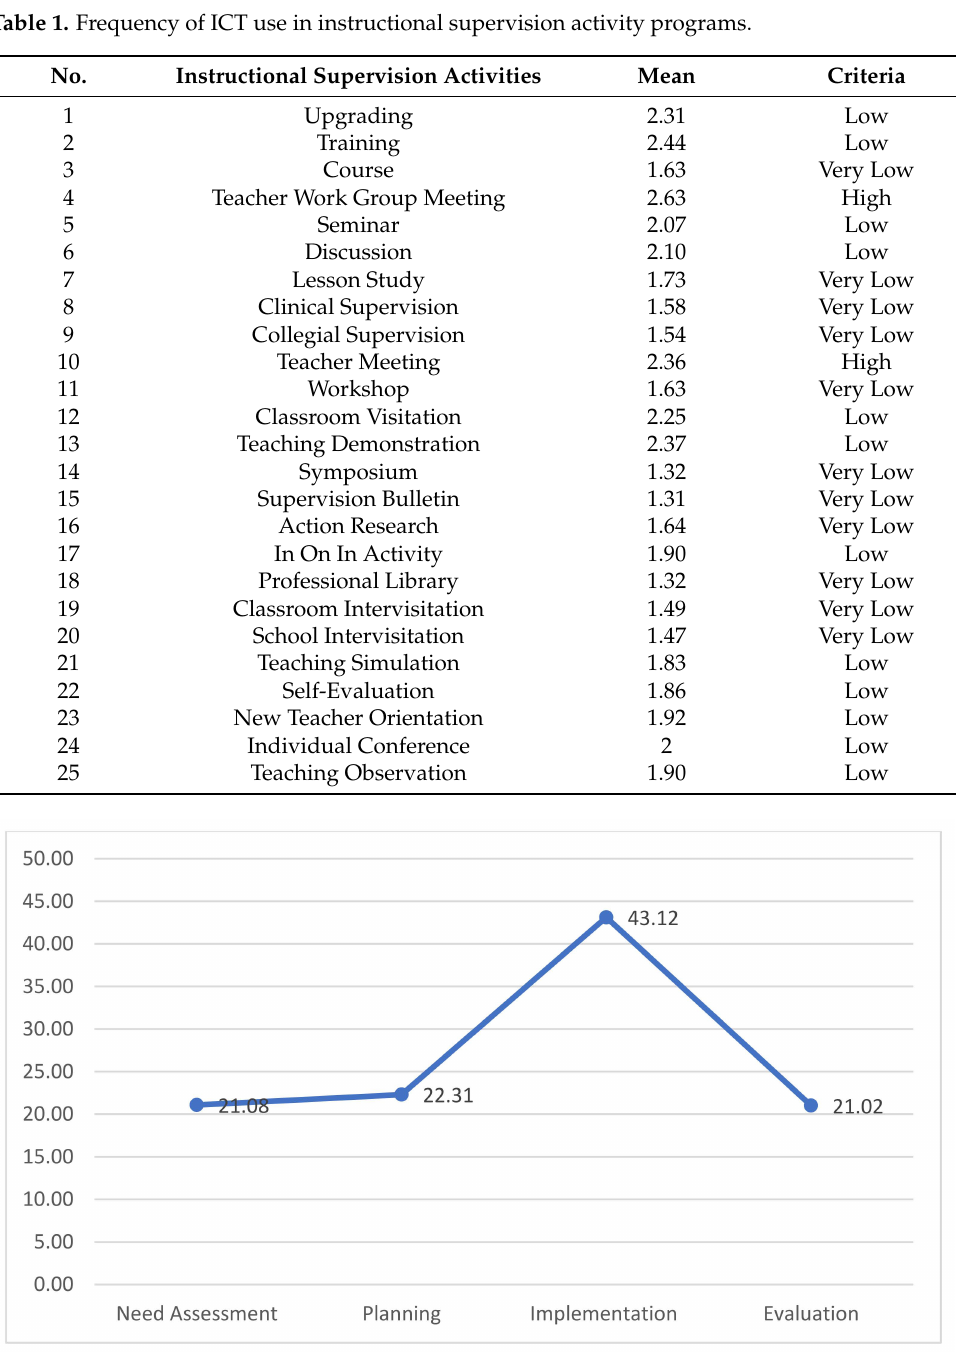
Figure 1. Use of ICT in the stages of instructional supervision